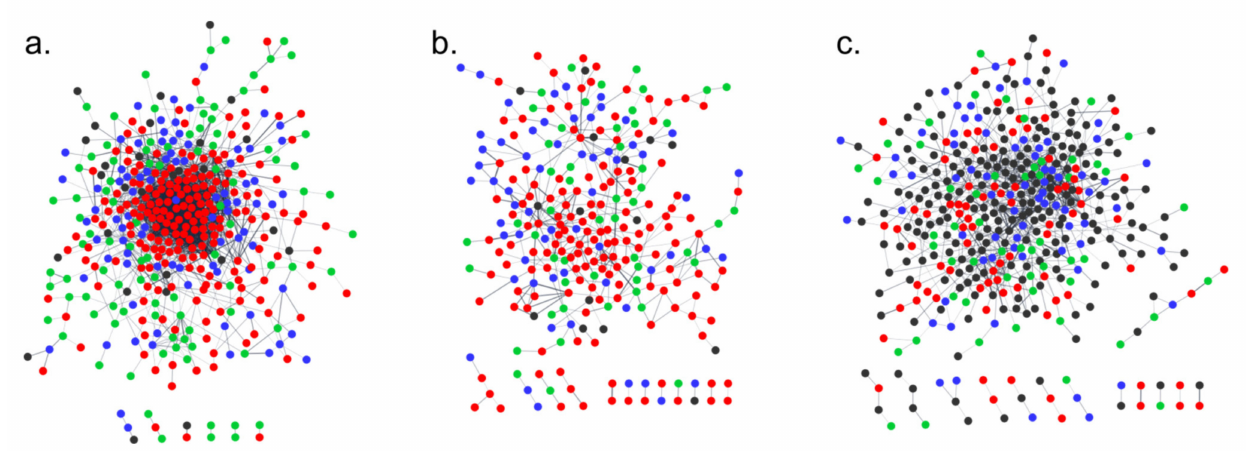
Figure 13. The results of STRING software analysis for protein–protein interaction network in S1 line ( a ), S2 line ( b ) and S3 line ( c ). The proteins coded by miRNA target genes are black, proteins coded by differentially regulated genes are red (up-regulated) and green (down-regulated), and proteins coded by genes with high impact polymorphism are